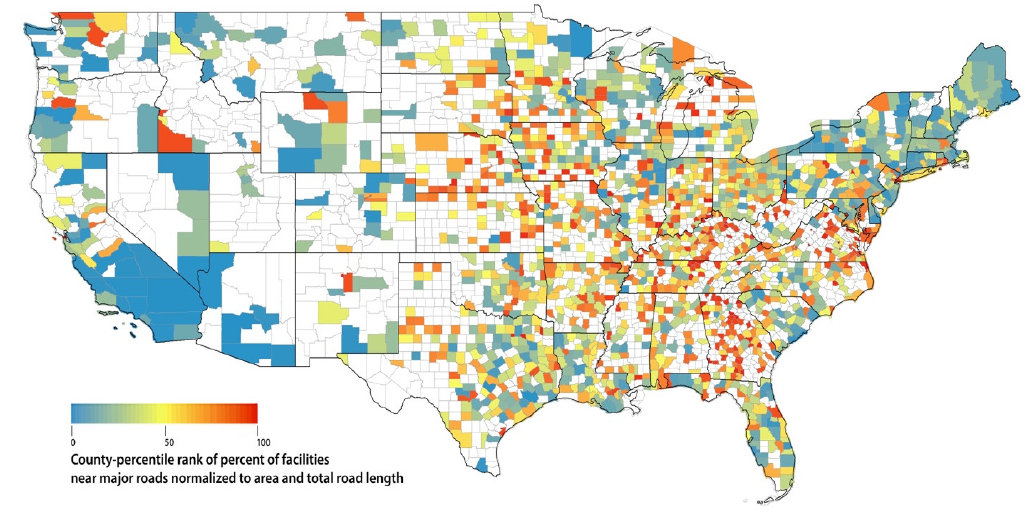
Figure 4. Percentile rank of percent of nursing facilities near major road, normalized to county area and total length of major roadways within each county. Blank indicates no nursing facility near major road in that county.